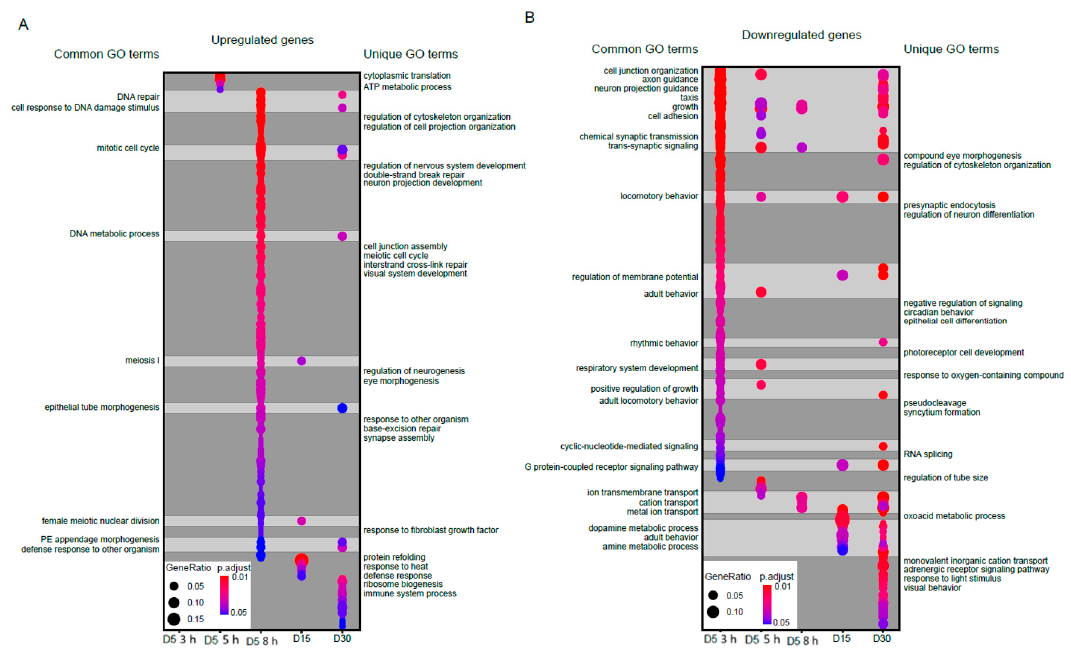
Figure 2. Significantly enriched GO terms for upregulated or downregulated genes. Dot plots of all enriched Gene Ontology (GO) terms for upregulated ( A ) or downregulated ( B ) genes in aged or blue light exposed flies relative to D5. Plots are shaded to highlight common (light grey) and unique (dark grey) GO terms between samples. Select GO terms of interest are annotated. A full list of GO terms is provided in Table